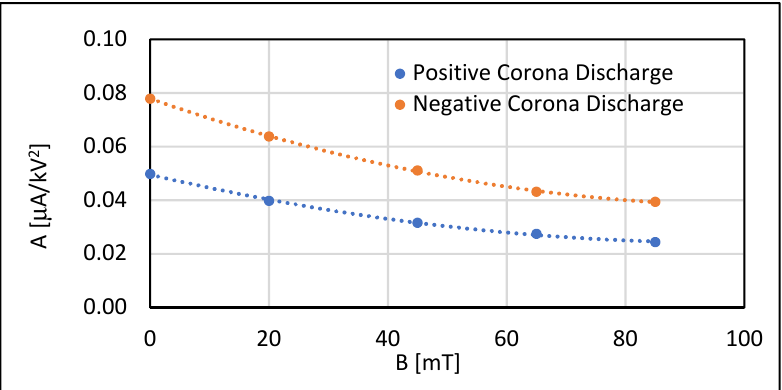
Figure 11. The variation of geometric factor A versus the crosse magnetic field B for both discharge polarities.